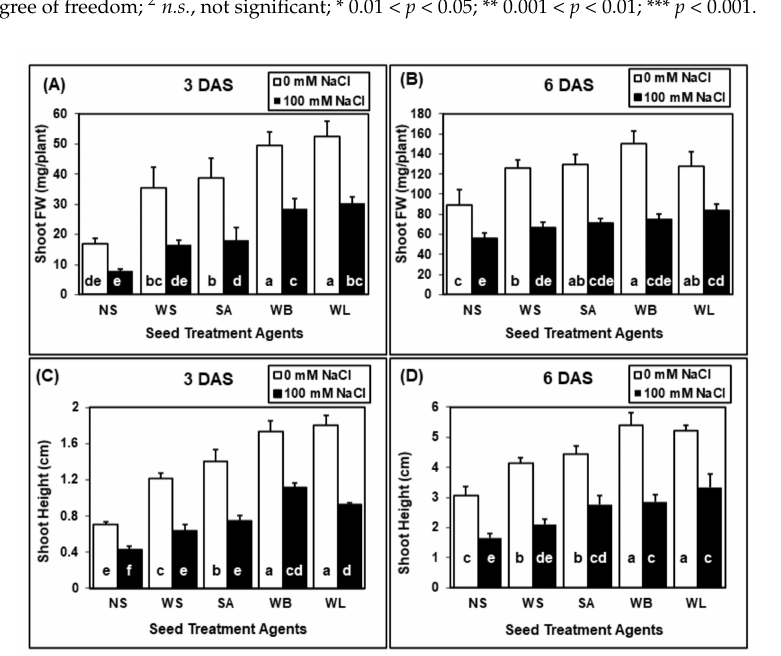
Figure 2. Effect of seed treatments (NS, non-soaked; WS, water-soaked; SA, salicylic acid (0.5 mM); WB, willow bark extract (2% w / v ); WL, willow leaf extract (2% w / v )) on shoot fresh weight (FW) ( A , B ) and height ( C , D ) of maize ( Zea mays cv. Caramelo) seedlings (( A , C ), 3 days after sowing (DAS); ( C , D ), 6 DAS) grown in perlite in the absence (0 mM NaCl) or presence (100 mM NaCl) of salinity